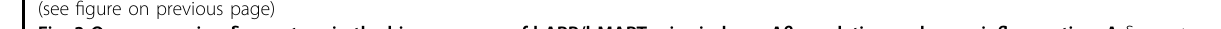
Fig. 3 Overexpression δ -secretase in the hippocampus of hAPP/hMAPT mice induces A β escalation and neuroin fl ammation. A δ -secretase enzymatic assay. AEP enzymatic activity assay showed AEP activity in all the four lines of mice injected with AAV-AEP and AAV-Control virus. δ - secretase was increased in the hAPP/hMAPT mice, and overexpression of δ -secretase displayed the highest activities in hAPP/hMAPT double- transgenic mice (Mean± SEM, n = 6 mice for each group, two-way ANOVA with Bonferroni multiple-comparisons test. * as compared to the WT mice + AAV-Control Virus; # as compared to the WT mice + AAV-AEP virus; $ as compared to AAV-Control virus in same mouse strain). B ELISA analysis of neuroin fl ammation factors IL-6 in the brain lysates from four lines of mice treated with AAV-AEP and AAV-Control virus (Mean ± SEM, n = 6 mice for each group, two-way ANOVA with Bonferroni multiple-comparisons test. * as compared to WT mice + AAV-Control virus; # as compared to the WT mice + AAV-AEP virus; $ as compared to AAV-Control virus in same mouse strain). C ELISA analysis of neuroin fl ammation factors IL-1 β in the brain lysates from four lines of mice treated with AAV-AEP and AAV-Control virus (Mean± SEM, n = 6 mice for each group, two-way ANOVA with Bonferroni multiple-comparisons test. * as compared to WT mice + AAV-Control virus; # as compared to the WT mice + AAV-AEP virus; $ as compared to AAV-Control virus in same mouse strain). D ELISA analysis of neuroin fl ammation factors TNF α in the brain lysates from four lines of mice treated with AAV-AEP and AAV-Control virus (Mean± SEM, n = 6 mice for each group, two-way ANOVA with Bonferroni multiple-comparisons test. * as compared to WT mice + AAV-Control virus; # as compared to the WT mice + AAV-AEP virus; $ as compared to AAV-Control virus in same mouse strain). E ELISA analysis of human A β 42 in the brain lysates from four lines of mice treated with AAV-AEP and AAV-Control virus. (Mean± SEM, n = 6 mice for each group, two-way ANOVA with Bonferroni multiple-comparisons test. * as compared to WT mice + AAV-Control virus; # as compared to the WT mice + AAV-AEP virus; $ as compared to AAV-Control virus in same mouse strain). F ELISA analysis of human A β 40 in the brain lysates from four lines of mice treated with AAV-AEP and AAV-Control virus. (Mean ± SEM, n = 6 mice for each group, two-way ANOVA with Bonferroni multiple- comparisons test. * as compared to WT mice + AAV-Control virus; # as compared to the WT mice + AAV-AEP virus; $ as compared to AAV-Control virus in same mouse strain). G ELISA analysis of mouse A β 42 in the brain lysates from four lines of mice treated with AAV-AEP and AAV-Control virus. (Mean± SEM, n = 6 mice for each group, two-way ANOVA with Bonferroni multiple-comparisons test. * as compared to WT mice + AAV-Control virus; # as compared to the WT mice + AAV-AEP virus; $ as compared to AAV-Control virus in same mouse strain). H ELISA analysis of mouse A β 40 in the brain lysates from four lines of mice treated with AAV-AEP and AAV-Control virus. (Mean± SEM, n = 6 mice for each group, two-way ANOVA with Bonferroni multiple-comparisons test. * as compared to WT mice + AAV-Control virus; # as compared to the WT mice + AAV-AEP virus; $ as compared to AAV-Control virus in same mouse strain). ( I ) Immunohistochemistry characterization of A β and AT8. The hippocampal sections of the indicated mice infected with AAV-AEP and AAV-Control virus were stained with anti-A β or AT8. Overexpression of δ -secretase increased A β and p- Tau signals in the double-transgenic mice (left, scale bar: 30 μ m). Quantitative analysis of the immunohistochemical signals in each group (right, Mean±SEM, n = 6 mice for each group, two-way ANOVA with Bonferroni multiple-comparisons test. * as compared to WT mice + AAV-Control